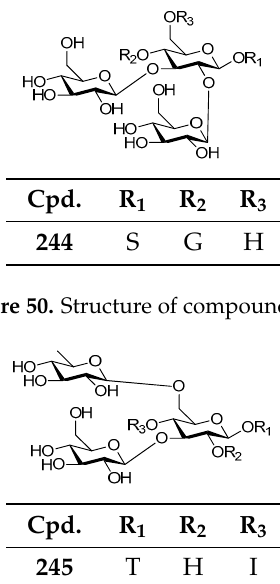
Figure 49. Structure of compound 243 .